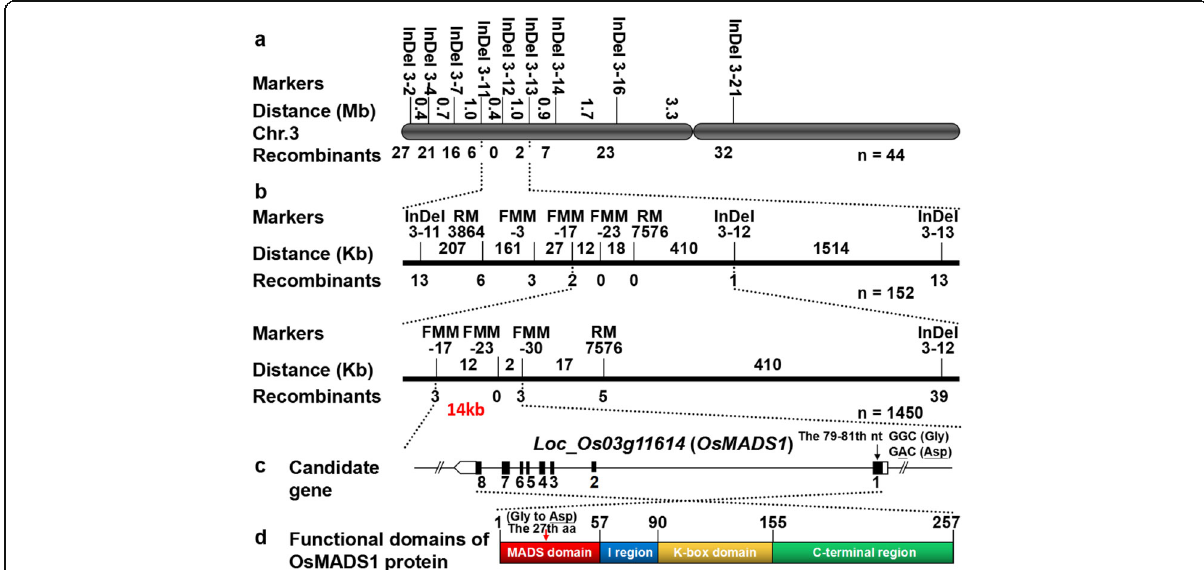
Fig. 6 Map-Based Cloning of the OsMADS1 Olr gene. a Location of the OsMADS1 Olr gene on the long arm of chromosome 3. Numerals indicate physical distance between the adjacent markers. Numerals below the schematic diagram of chromosome 3 represent recombinants. b Fine mapping of the OsMADS1 Olr gene. Numerals above and below the bar represent physical distance and recombinants, respectively. c Schematic representation of gene structure of the OsMADS1 . The nucleotide substitution site in OsMADS1 Olr is indicated by a black arrow. Exons are shown as closed boxes; introns are shown as straight lines; and untranslated regions (UTRs) are marked with open boxes. nt, nucleotide. d Schematic representation of OsMADS1 protein with functional domains. Functional domains of OsMADS1 with corresponding locations are shown. The amino acid substitution site in OsMADS1 protein is indicated by a red arrow. aa, amino